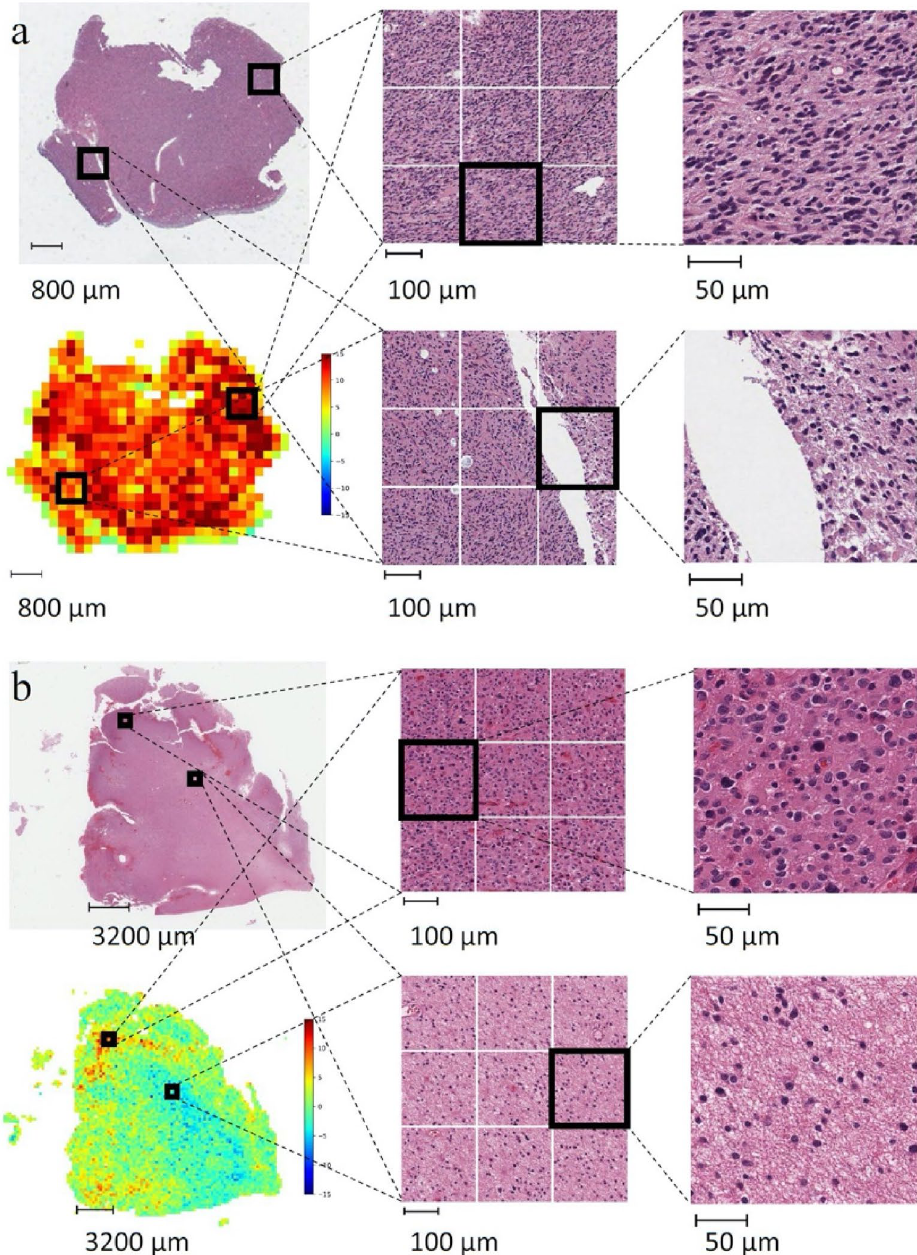
Figure 2. Example predictions on whole slide images for prognosis prediction. ( a ) A 59-year-old female patient diagnosed with mixed glioma, died 1.4 years after diagnosis. The predicted risk score is 10.77. ( b ) A 32-year-old man diagnosed with mixed glioma, died 6 years later. The predicted risk score is